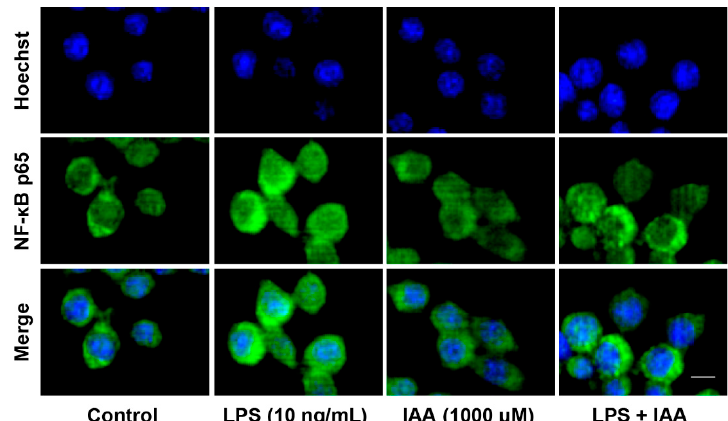
Figure 3. LPS-induced nuclear translocation of NF- κ B p65 was alleviated by IAA treatment. Cells were pretreated with IAA (1000 µM) for 12 h before 2 h LPS (10 ng/mL) stimulation, after which NF- κ B p65 was determined by immunofluorescence. Scale bar represents 10 µ m. IAA, indole-3-acetic acid; LPS, lipopolysaccharide; NF- κ B, nuclear factor kappa